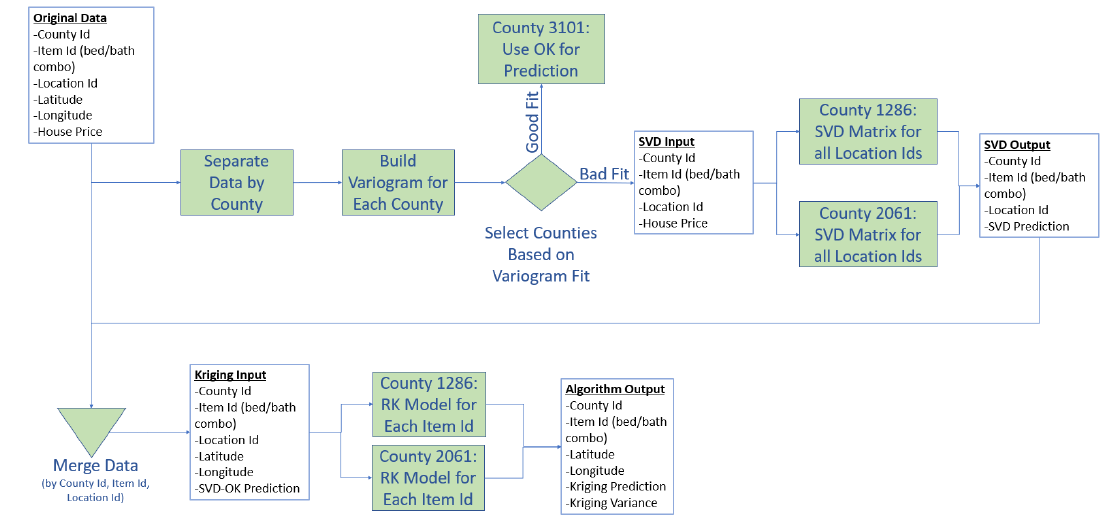
Figure 4. Methodology Flowchart.